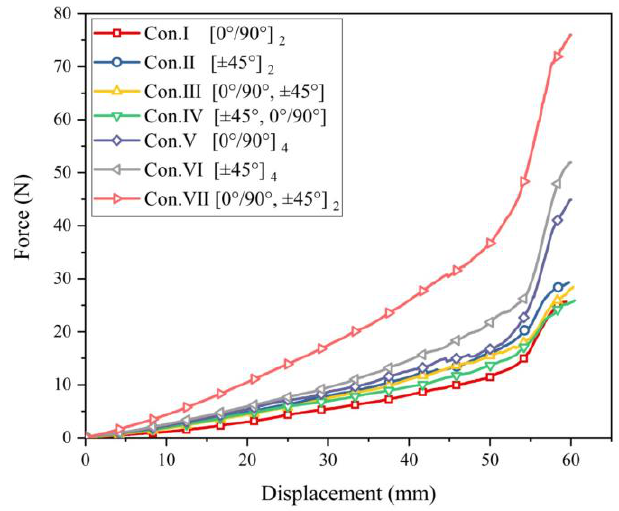
Figure 22. Punch force under different configurations in multi-layer preforming.